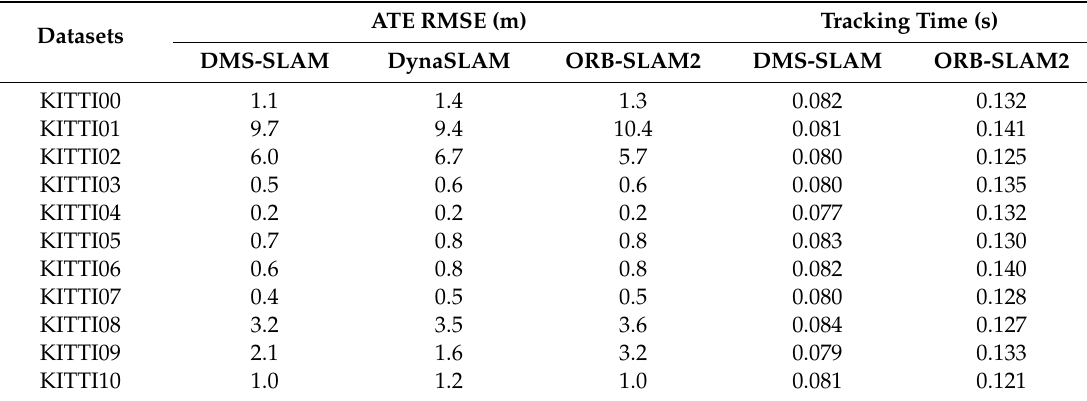
Table 4. Positioning accuracy and tracking time of stereo vision SLAM on KITTI datasets.